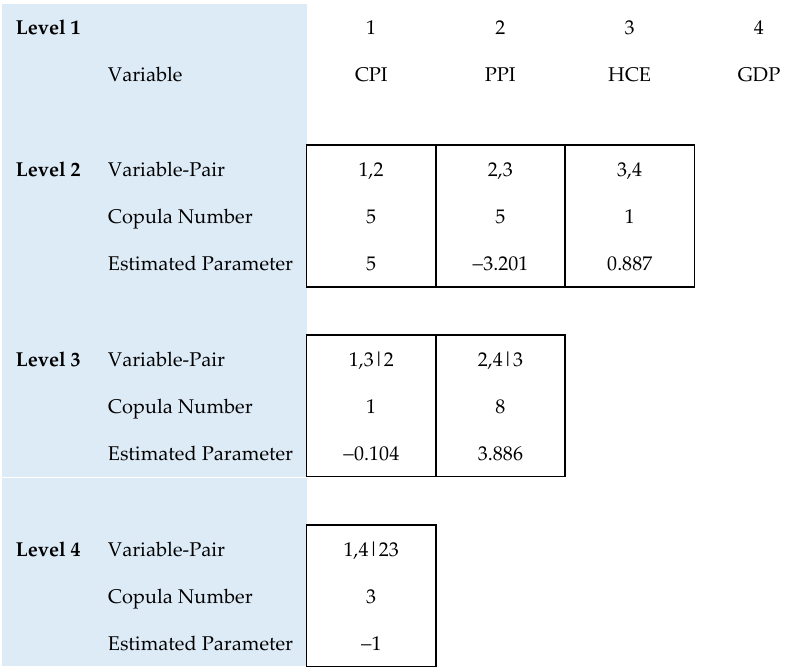
Figure 5. D-vine copula fitted to the economic variables {CPI, PPI, HCE, GDP} using quarterly data from 2010 to 2018.